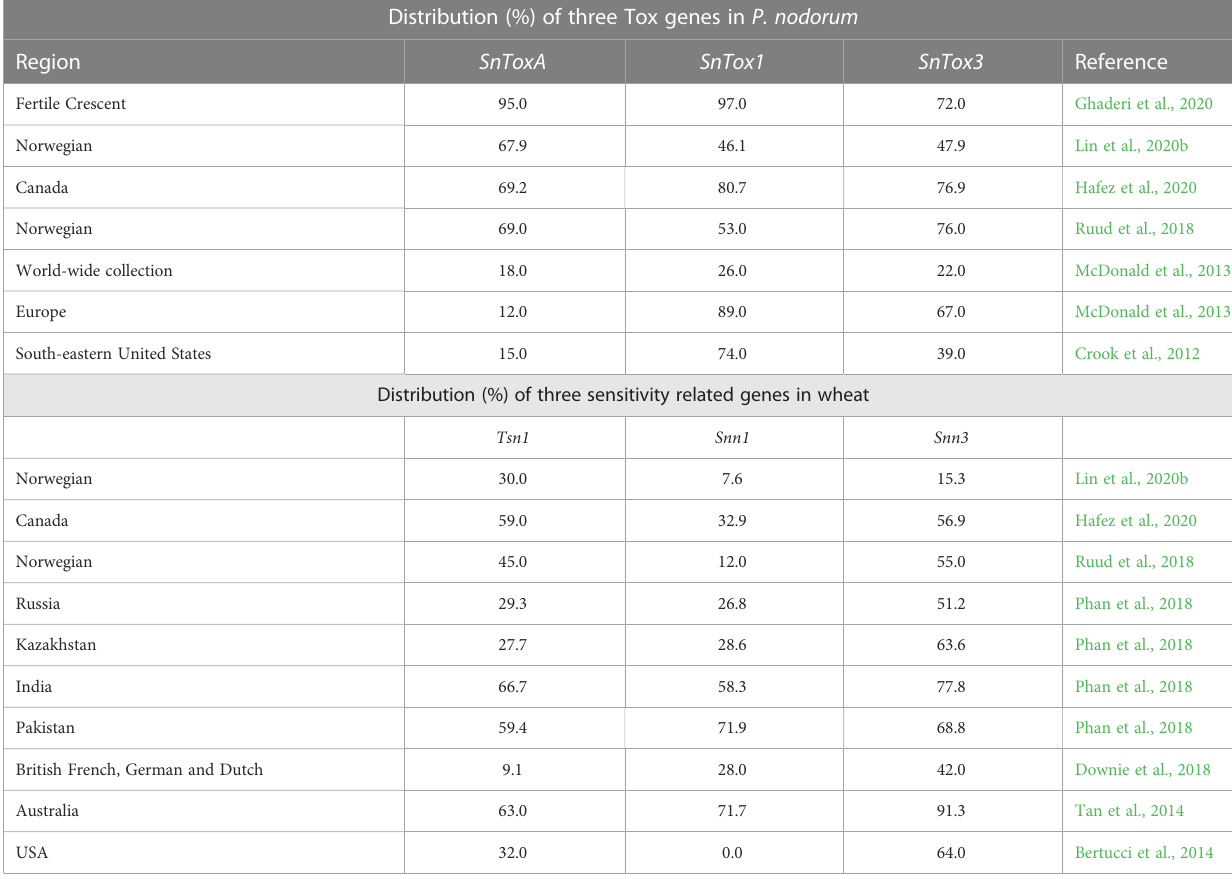
TABLE 3 Distribution (%) of three Tox genes among isolates of P. nodorum and sensitivity genes in wheat. Distribution (%) of three Tox genes in P.